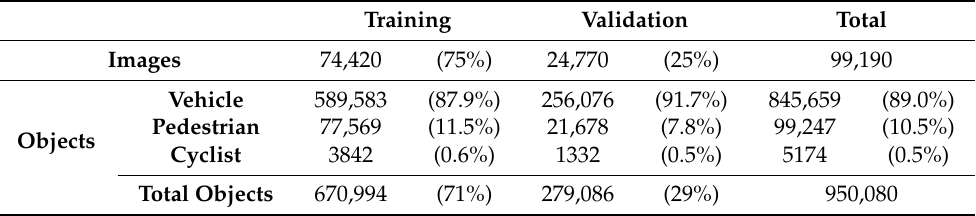
Table 1. Distribution of object instances in the training and validation